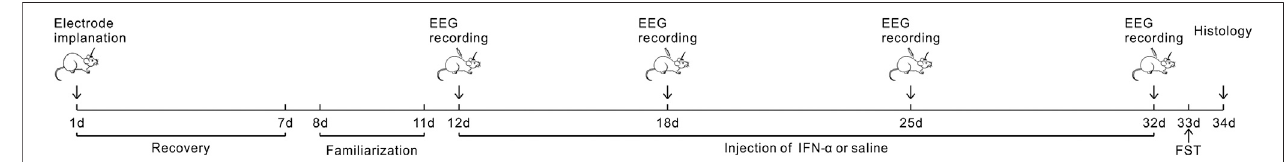
FIGURE 1 | Experimental Design: the mice experienced surgery for electrode implantation and 7 days of recovery. The fi rst EEG recording was conducted after 4 days of familiarization to the recording environments. Then IFN- α or saline was administered for 3 weeks. EEG recording was repeated at 7, 14, and 21 days after treatment. FST was conducted at the 21 days after EEG recording; then the brain was collected in the next